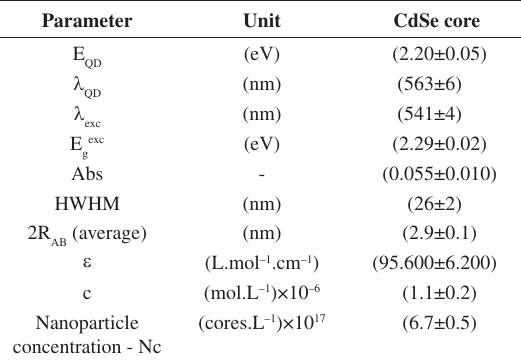
Table 1. Quantum dot parameters.